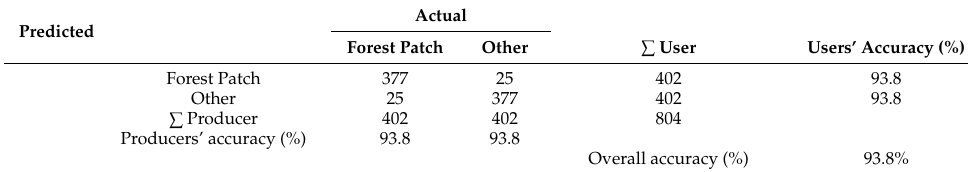
Table 2. Validation error matrix.